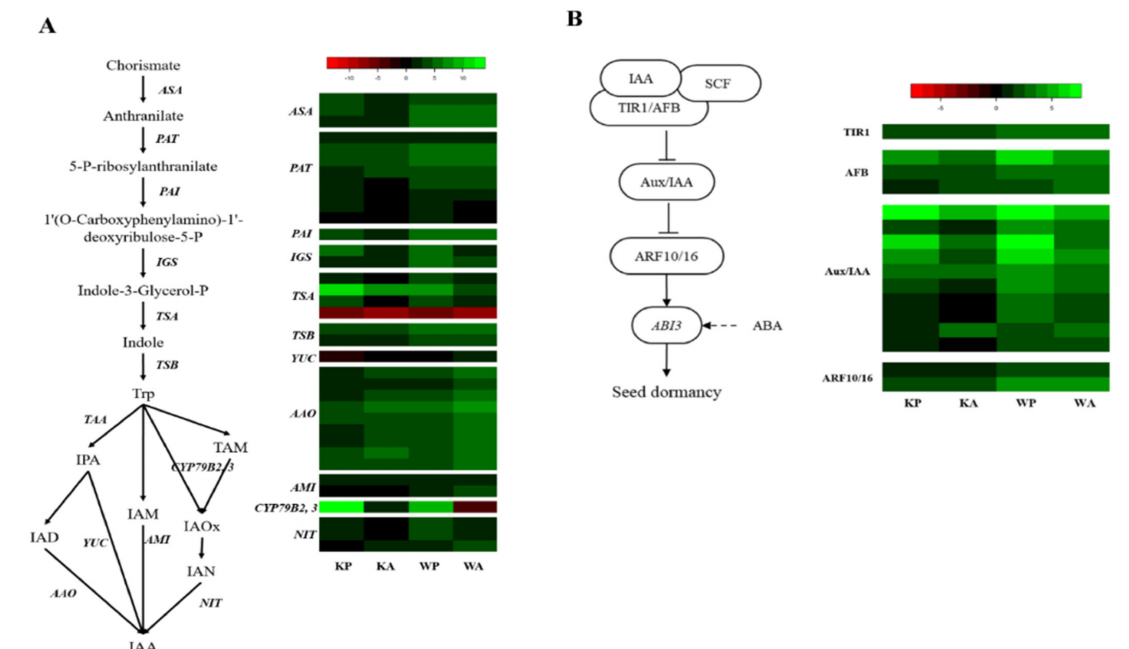
Figure 4. Heat map analysis of DEGs from PHS and ABA treatment for indole-3-acetic acid (IAA) hormone metabolism and signaling: ( A ) hormone metabolism pathway of IAA and comparative expression of genes related to IAA hormone metabolism; ( B ) signaling pathway of IAA and comparative expression of genes related to IAA signaling. The heatmap shows an expression change compared to the controls for each cultivar, with log2 fold-change values.